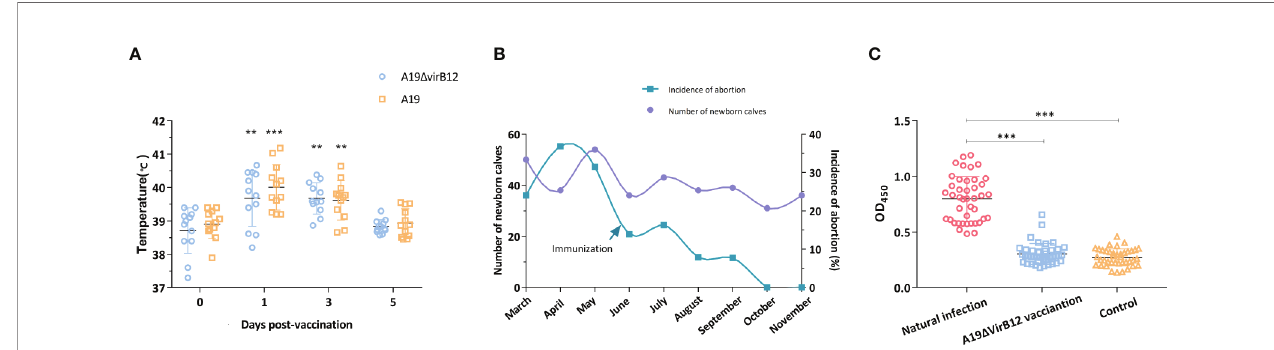
FIGURE 2 | Evaluation of A19 D virB12 vaccination in cattle. (A) Changes of body temperature after immunization. (B) Incidence of cattle abortion by month before and after A19 D virB12 immunization. (C) Immune response of VirB12 to sera with A19 D virB12 immunization or natural infection. The arrow in (B) represents the time